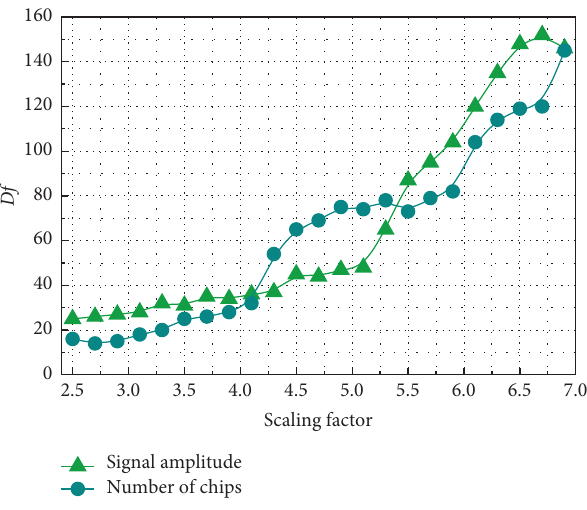
Figure 9: Total Cost Analysis. Figure 10: Manpower cost analysis interface